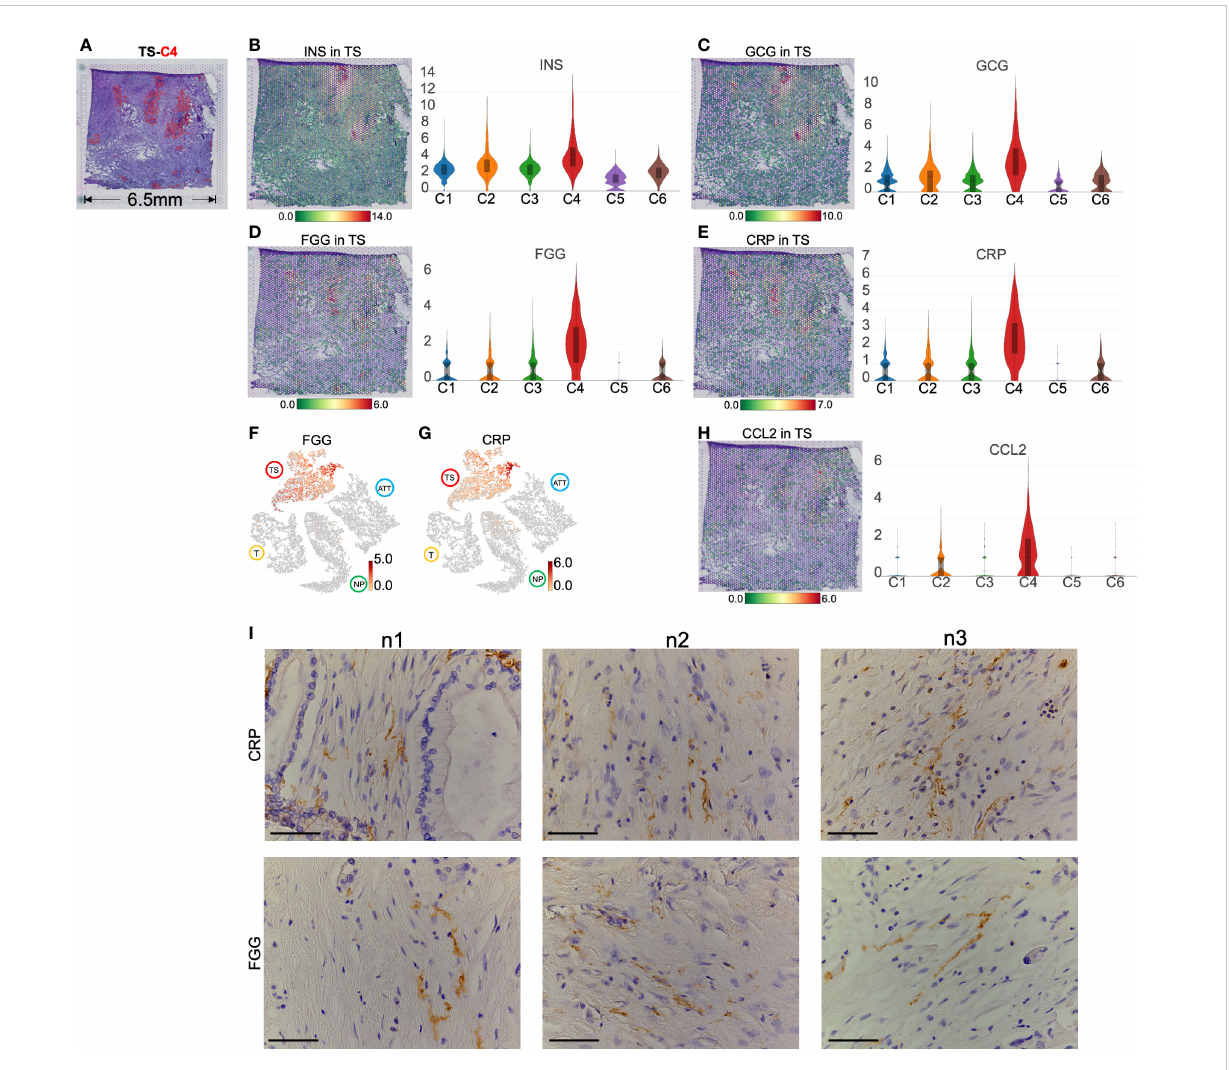
FIGURE 7 Marker genes and spatial distribution of tumor stroma (TS) -cluster (C)4. (A) Distribution of TS-C4 (the red spots) in hematoxylin and eosin images image. The level and distribution of INS (B) , GCG (C) , FGG (D) , and CRP (E) in TS. (F, G) The distribution and level of FGG and CRP across normal pancreas (NP), adjacent tumor tissue (ATT), tumor (T), and TS. (H) The level and distribution of CCL2 in TS. (I) Immunohistochemical staining of FGG and CRP in the TS from three pancreatic ductal adenocarcinoma tissue samples. The bar plots and the vertical coordinate of the violin plots indicates the log 2 FC of the gene expression value of each cluster versus the average gene value. Scale bar = 50 m